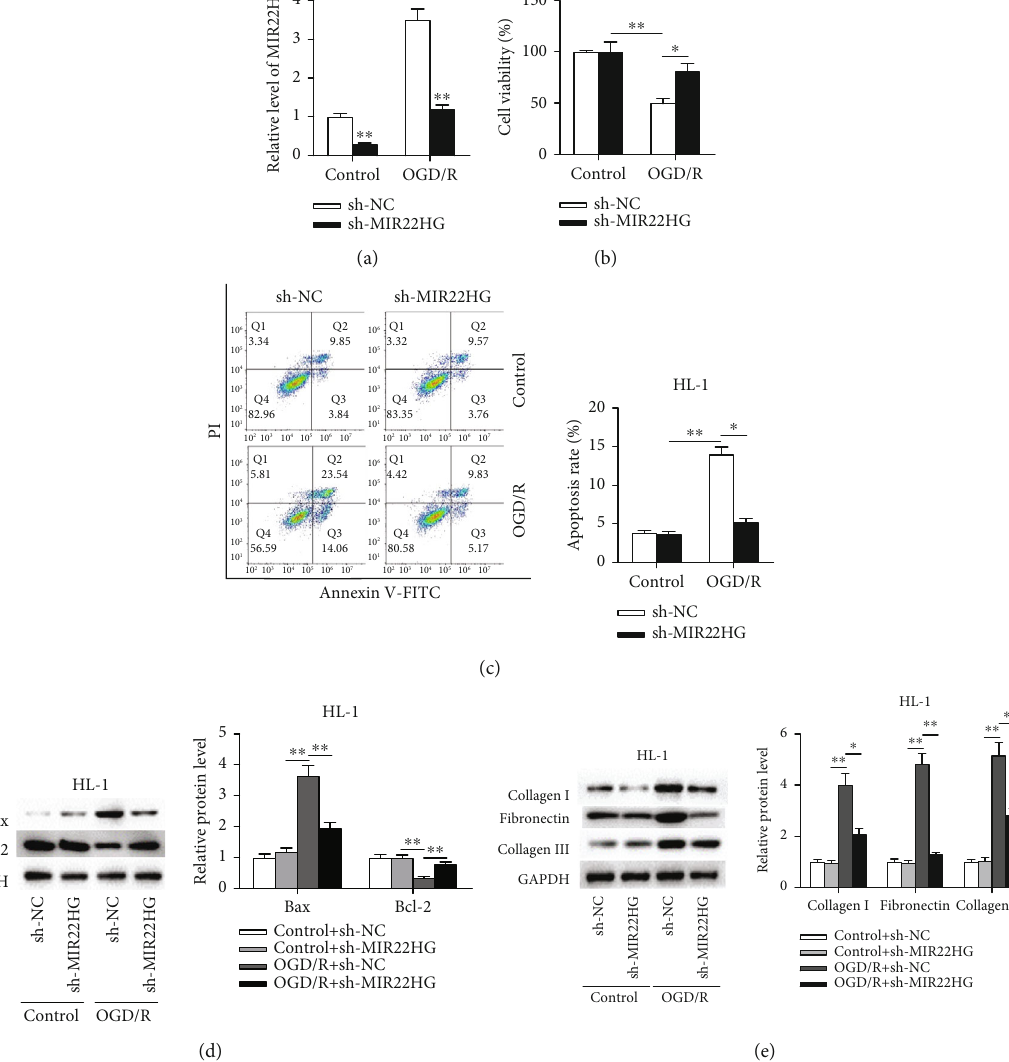
Figure 2: MIR22HG knockdown attenuated OGD/R-treated cardiomyocyte injury. (a) The knockdown e ffi ciency of sh-MIR22HG was determined by RT-qPCR ( n = 3 ). (b) The e ff ect of sh-MIR22HG on the viability of OGD/R-treated HL-1 cells was assessed by CCK-8 assay ( n = 3 ). (c) The e ff ect of sh-MIR22HG on the apoptosis of OGD/R-treated HL-1 cells was evaluated by fl ow cytometry analysis ( n = 3 ). (d and e) The e ff ect of sh-MR22HG on the protein levels of Bax, Bcl-2, collagen I, fi bronectin, and collagen III in OGD/R- treated HL-1 cells was measured by western blotting analysis ( n = 3 ). ∗ p < 0 : 05 , ∗∗ p < 0 : 01